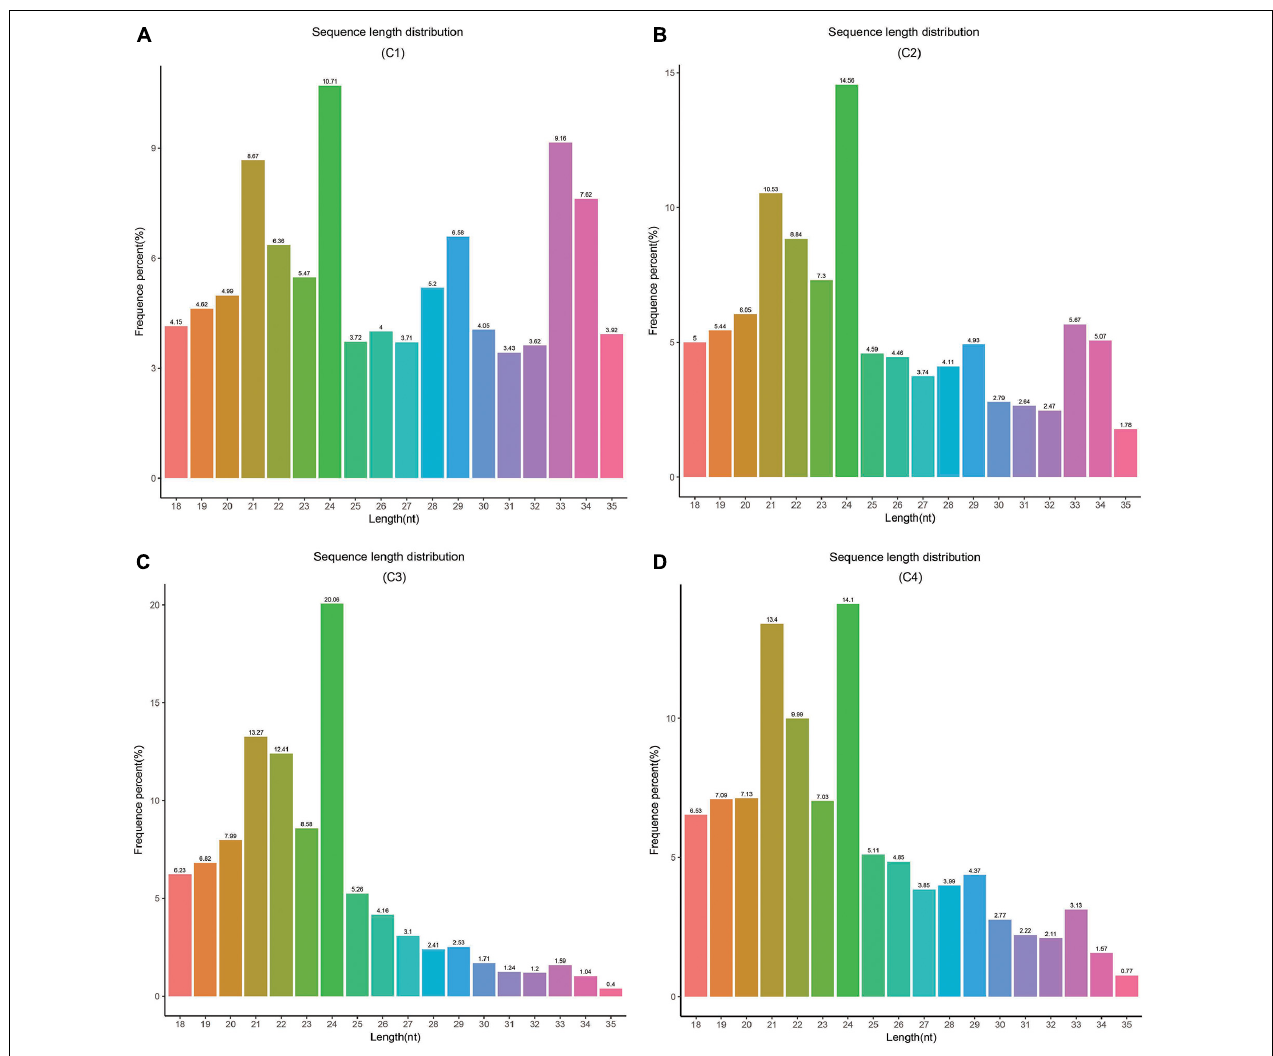
FIGURE 8 | Length distribution and abundance of small RNAs in four libraries from Pak-choi. (A) Frequence percentage (%) and length of sRNA distribution in C1 ( BcL.1-25 ) group. (B) Frequence percentage (%) and length of sRNA distribution in C2 ( BcL.1-4 ) group. (C) Frequence percentage (%) and length of sRNA distribution in the C3 ( BcL.2-25 ) group. (D) Frequence percentage (%) and length of sRNA distribution in the C4 ( BcL.2-4 )